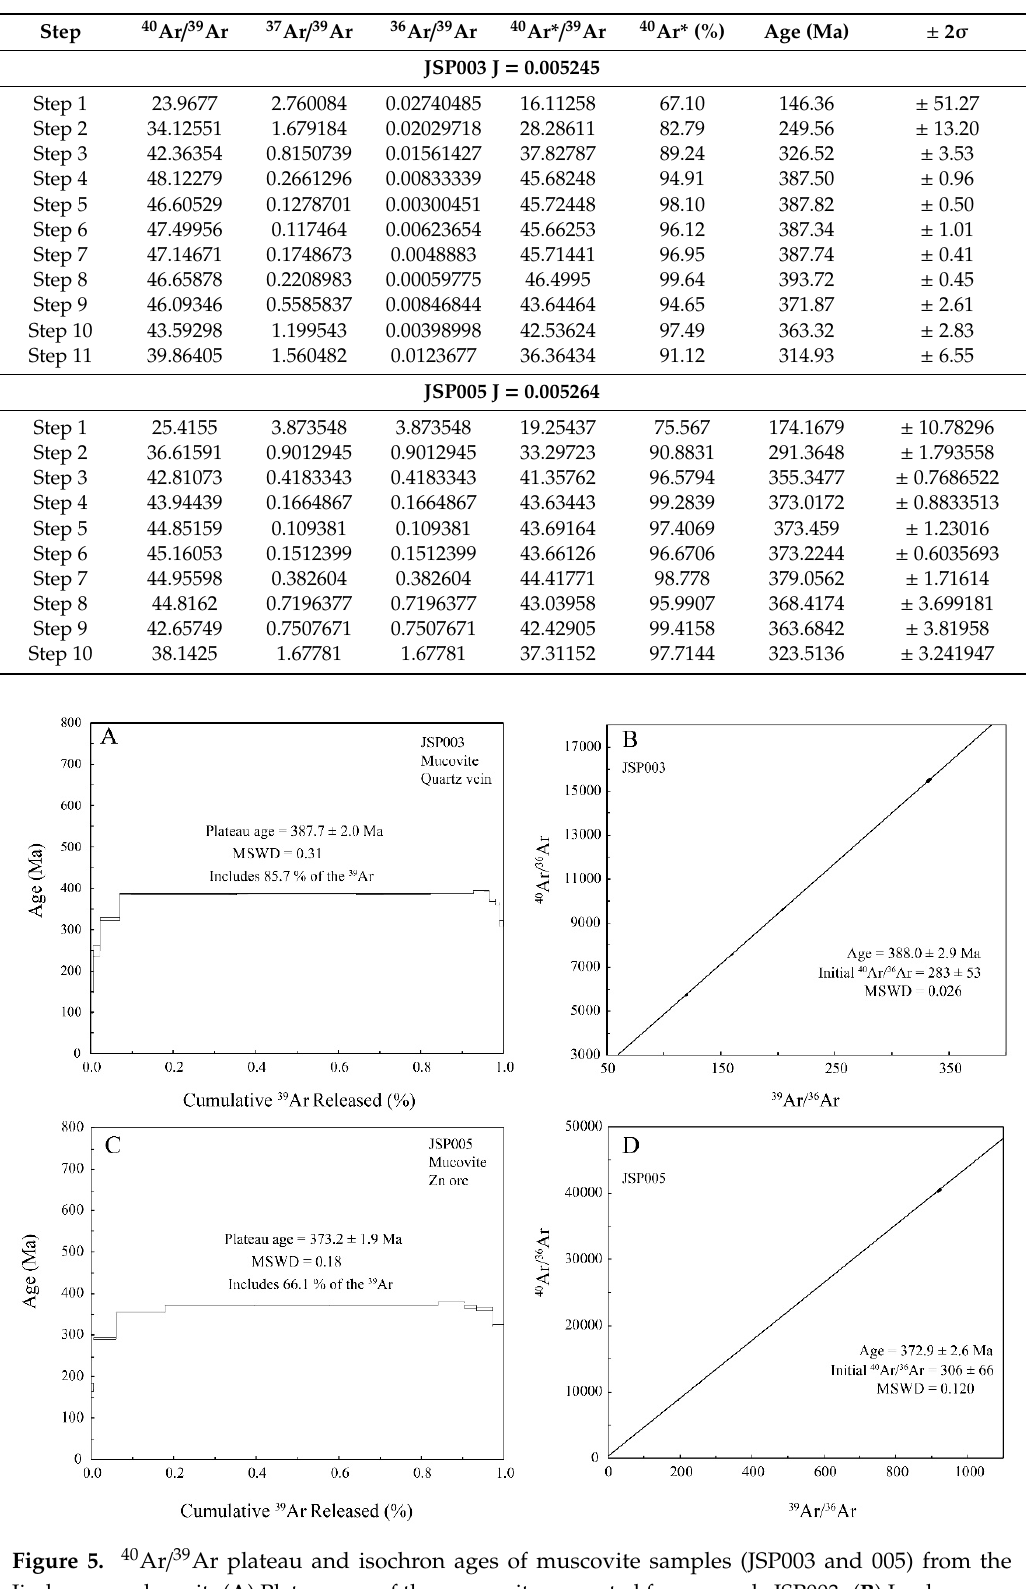
Table 1. 40 Ar / 39 Ar step-heating data of sample JSP003 and JSP005 at the Jiashengpan deposit.